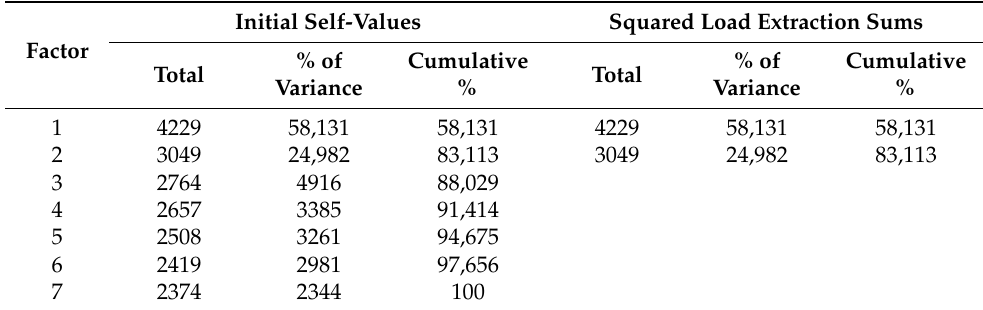
Table 3. Total variance explained after rotation of the selected factors; rescaled matrix maximum likelihood extraction method. Initial Self-Values Squared Load Extraction Sums Factor % of Cumulative Total Variance % Variance